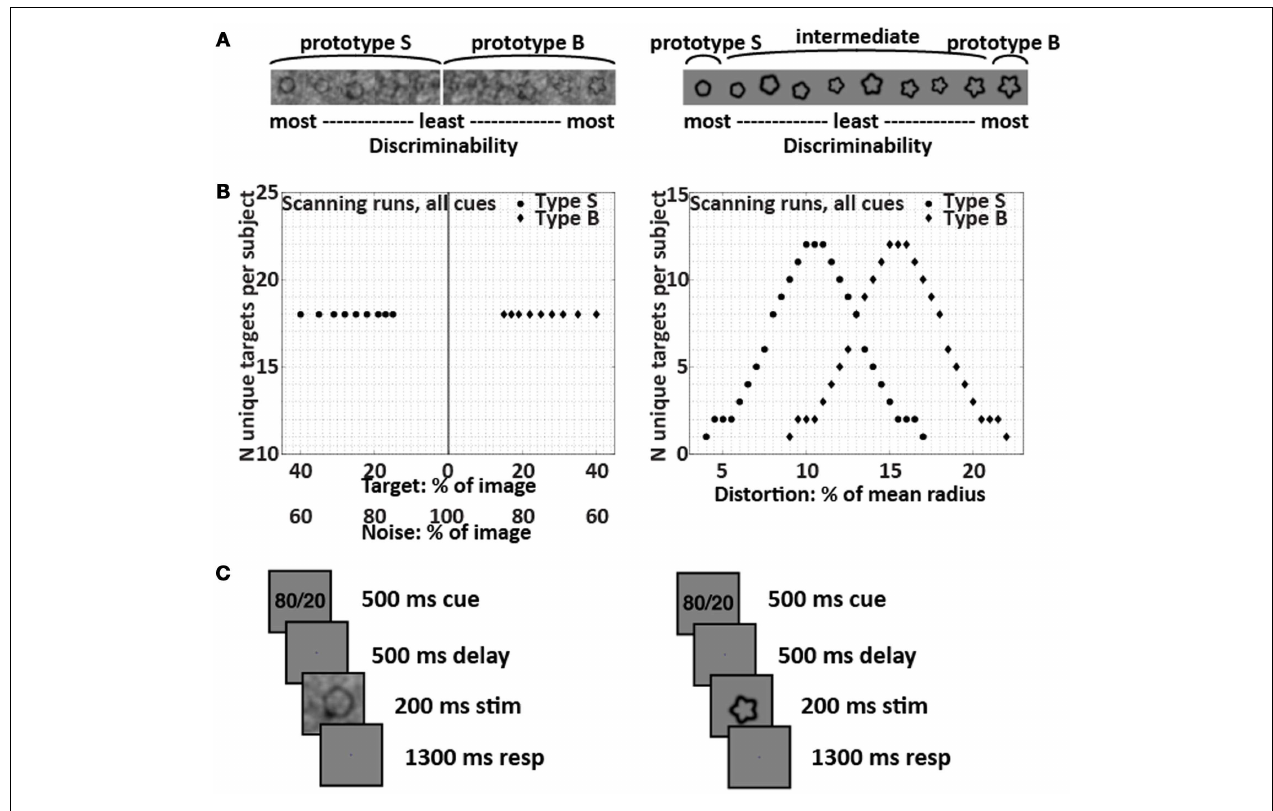
not overlaid with noise. (B) Target distributions used in all scanning runs for all subjects. (C) Trial structure in scanning runs.The subjects’ task was to decide whether each target belonged to Category S or B. Depending on subject group and run, the cue was 80/20, 50/50, or OO/OO.The set of images used to provide the 200-ms stimuli for the trials were identical across the 80/20, 50/50, and OO/OO scanning runs; only the cue